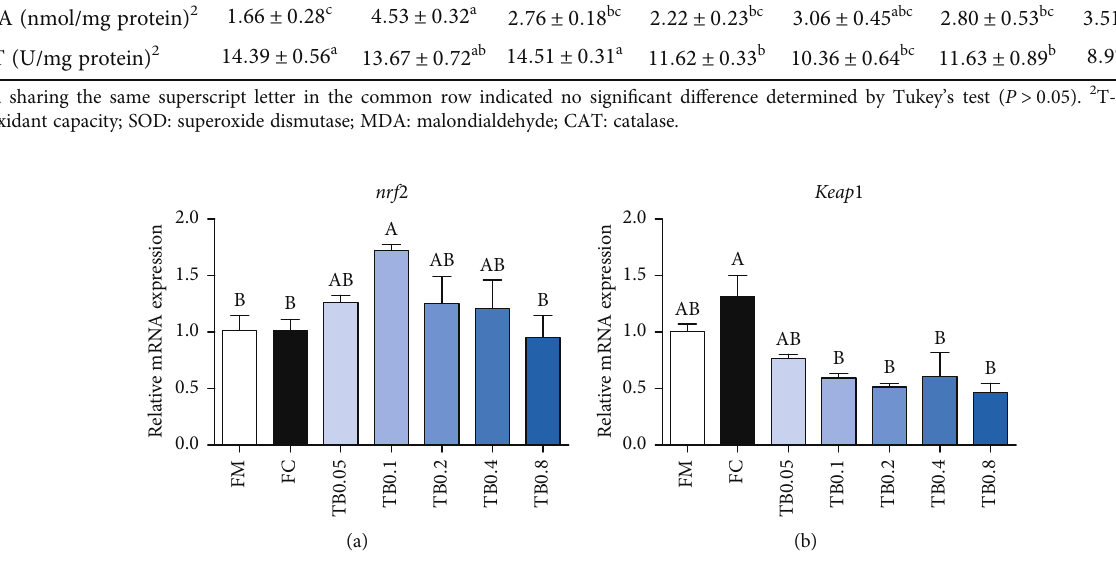
Figure 2: E ff ects of tributyrin supplementation on the expression of antioxidant-related genes in the intestine of juvenile large yellow croaker fed diets with high level of Clostridium autoethanogenum protein replacing fi sh meal. Values are means ( n = 3 ), with the vertical bars represent the standard error. Data in bars sharing the common letters indicated no signi fi cant di ff erence determined by Tukey ’ s test ( P > 0 : 05 ). nrf2 : nuclear factor erythroid 2-related factor 2; keap1 : Kelch-like ECH-associated protein